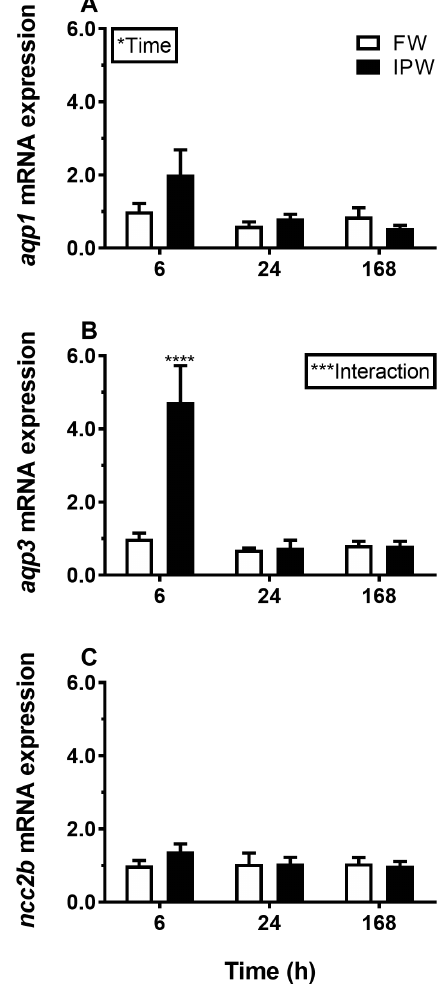
Figure 2. E ff ect of transfer from FW to 90% ion-poor water (IPW) on branchial AQP1 ( A ), AQP3 ( B ), and NCC2b ( C ) expression medaka at 6, 24, and 168 h timepoints. FW–FW sham transfer (open